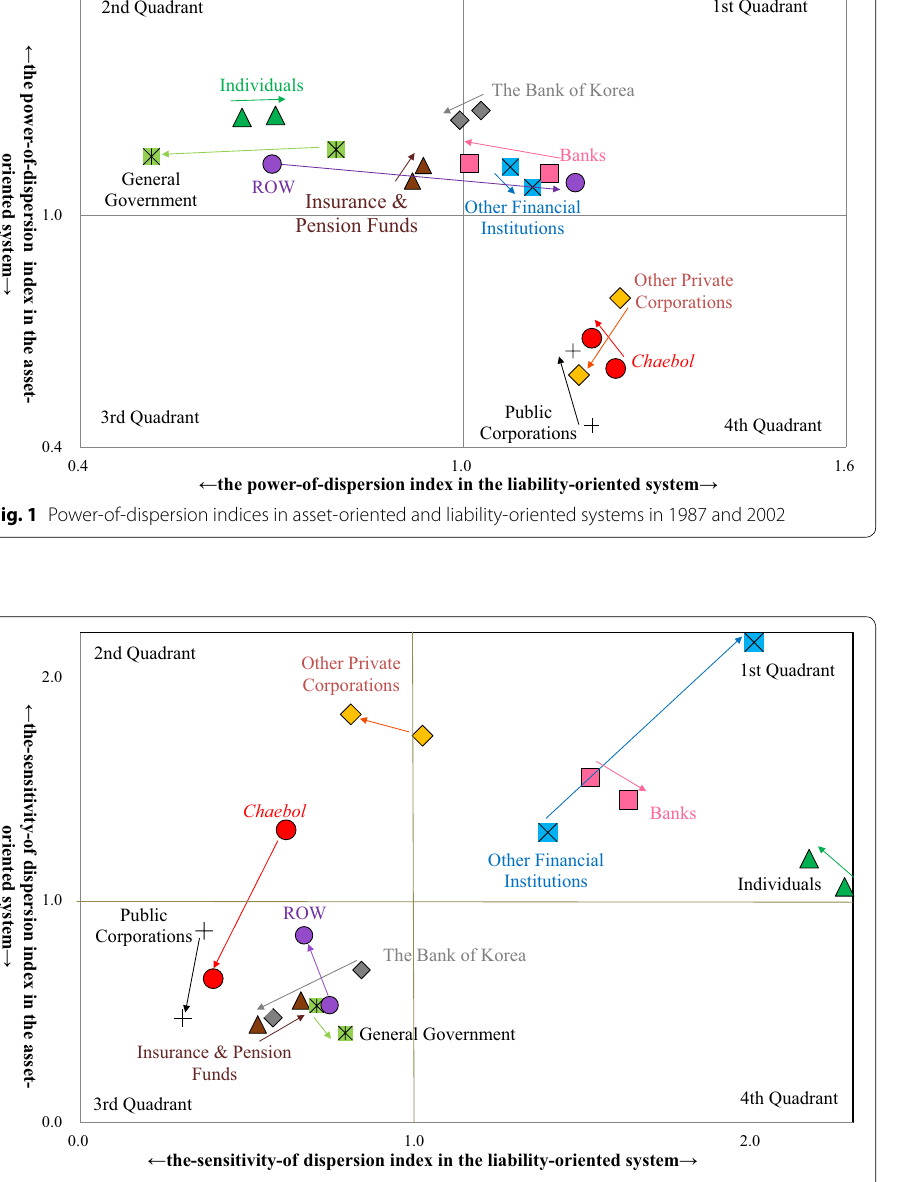
Fig. 2 Sensitivity-of-dispersion indices in asset-oriented and liability-oriented systems in 1987 and